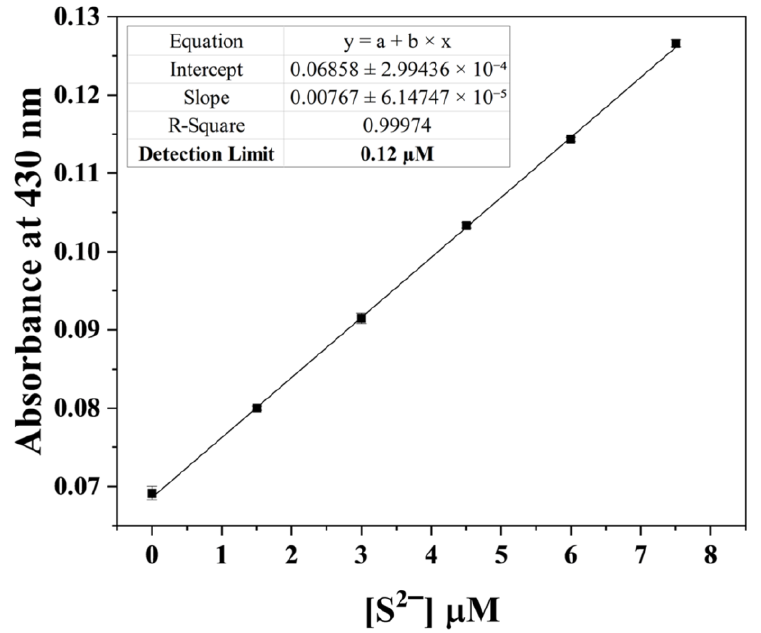
Figure 8. Calibration curve for S 2− analysis using HDHT – Cu 2+ plotted against absorbance at 430 nm ( n = 3).